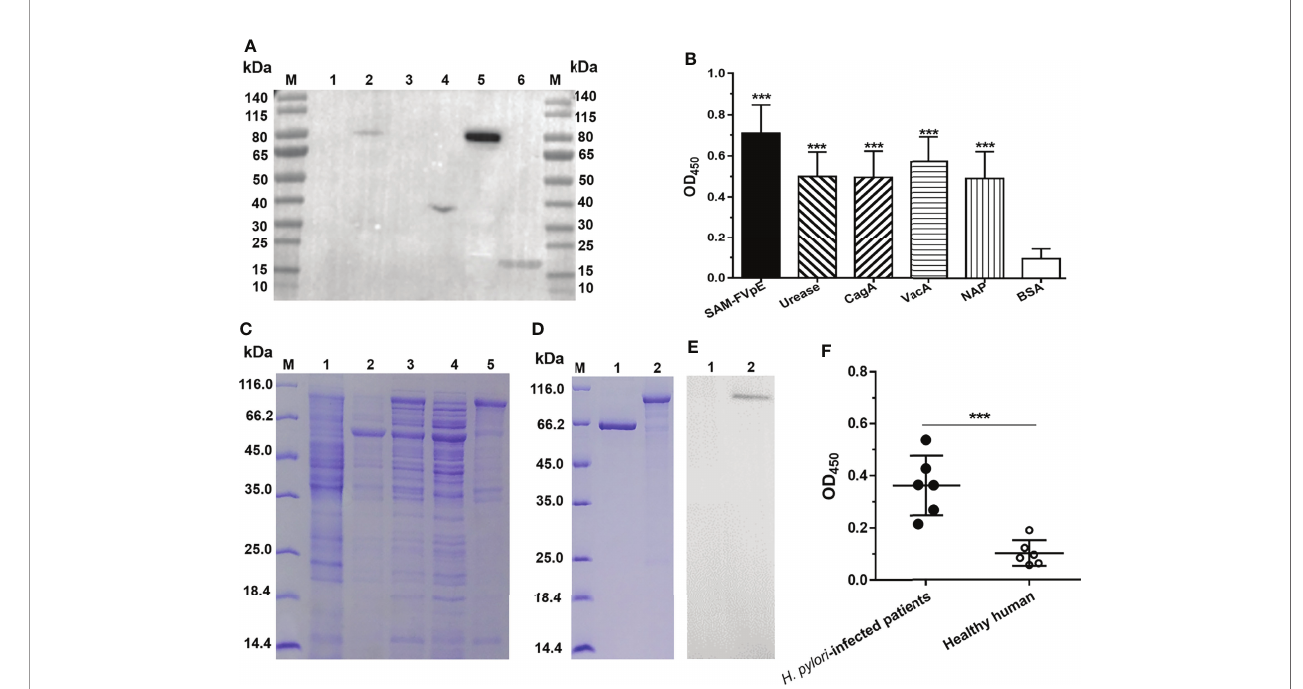
FIGURE 3 | Speci fi city of antiserum speci fi c for LL-plSAM-FVpE and immunoreactivity of the vaccine antigen SAM-FVpE. Antisera were prepared by oral vaccination of mice with LL-plSAM-FVpE. (A) Western blot. The antisera speci fi c for LL-plSAM-FVpE can recognize ( H ) pylori antigens. Protein marker (lane M), BSA (lane 1, 3), ( H ) pylori urease (lane 2), recombinant CagA (lane 4), VacA (lane 5), and NAP (lane 6). (B) ELISA. The plates were coated with 0.5 m g/well of SAM-FVpE, urease, CagA, VacA, NAP and BSA. The antisera speci fi c for LL-plSAM-FVpE was diluted to 1:500. ***p <0.001. (C) Expression of the vaccine antigen SAM-FVpE in (E) coli. Protein marker (lane M), ArcticExpress (DE3)/pCZN1 (lane 1), ArcticExpress (DE3)/peSAM-FVpE without IPTG induction (lane 2), ArcticExpress (DE3)/peSAM-FVpE with IPTG induction (lane 3), the soluble proteins of ArcticExpress (DE3)/peSAM-FVpE with IPTG induction (lane 4), the inclusion bodies of ArcticExpress (DE3)/ peSAM-FVpE with IPTG induction (lane 5). (D) Puri fi cation of the vaccine antigen SAM-FVpE. Protein marker (lane M), BSA (lane 1), SAM-FVpE (lane 2). (E) Western blot. The SAM-FVpE proteins could react speci fi cally with antiserum speci fi c for LL-plSAM-FVpE. BSA (lane 1), SAM-FVpE (lane 2). (F) ELISA. The sera from ( H ) pylori -infected patients could recognize the SAM-FVpE protein. The sera were diluted 100 times. ***p